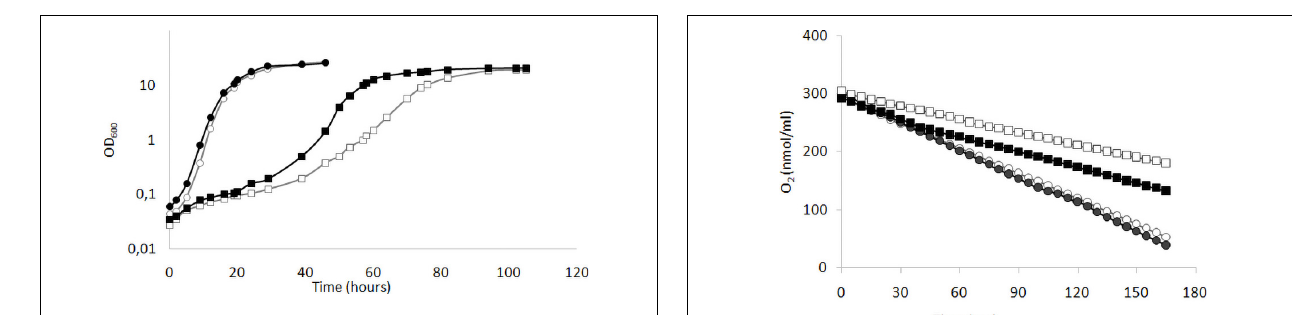
FIGURE 1 | Growth profiles of Klmga2 (cid:49) strain in light or dark exposure. Typical growth curves of the wild type MWL9S1 (circles) and the Klmga2 (cid:49) mutant strains (squares) in standard YPD medium are reported as optical density (OD 600 ) vs. time (hours). Black and white symbols refer to darkness and light cultivation, respectively. Repeated experiments gave similar results.